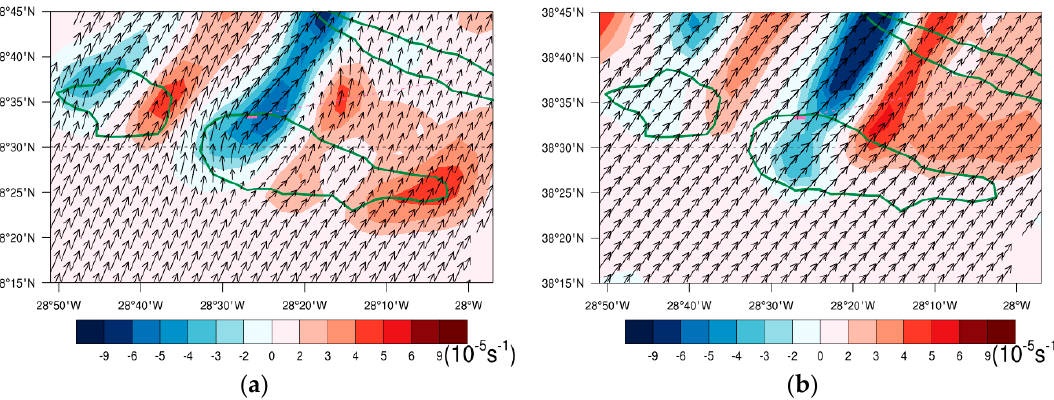
Figure 8. AROME absolute vorticity and wind vectors for Flight 1 at an altitude of: ( a ) 30 m; ( b ) 500 m. Dark arrows represent wind vectors.